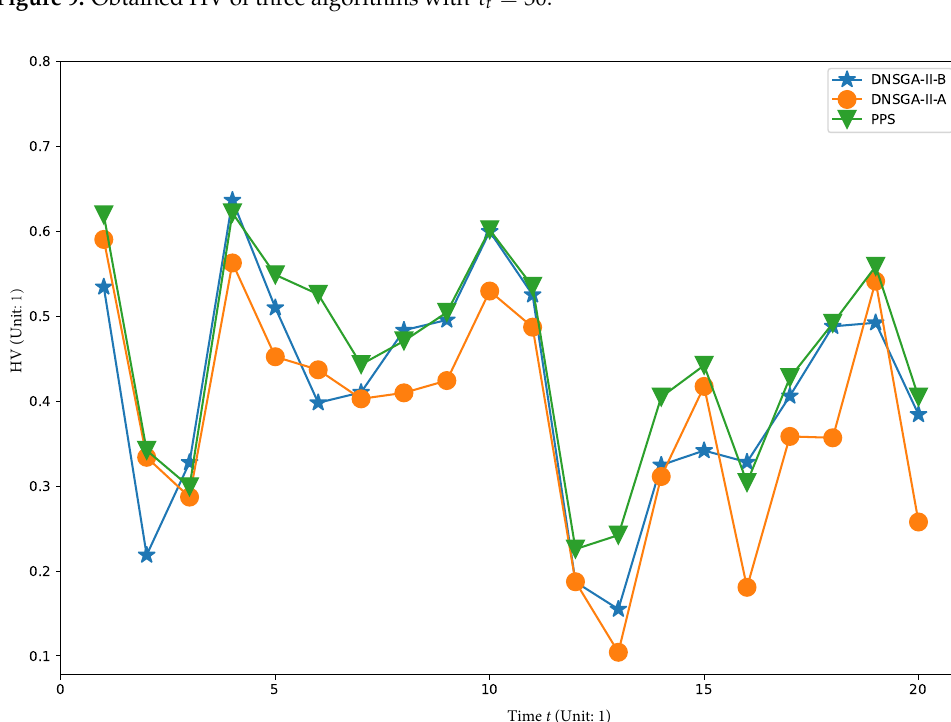
Figure 10. Obtained HV of three algorithms with τ t =